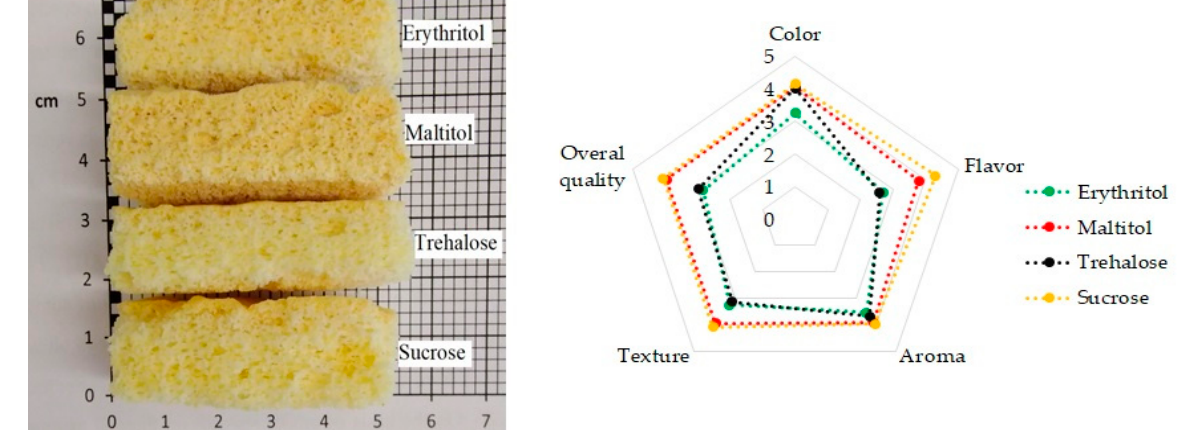
Figure 4. Sensory properties of sponge cakes with sweetener.